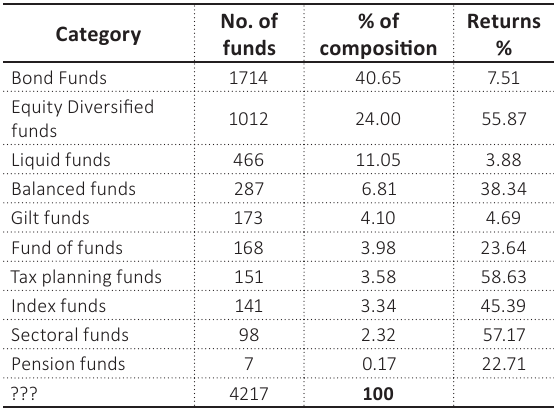
Table 2. Corpus size of the mutual funds